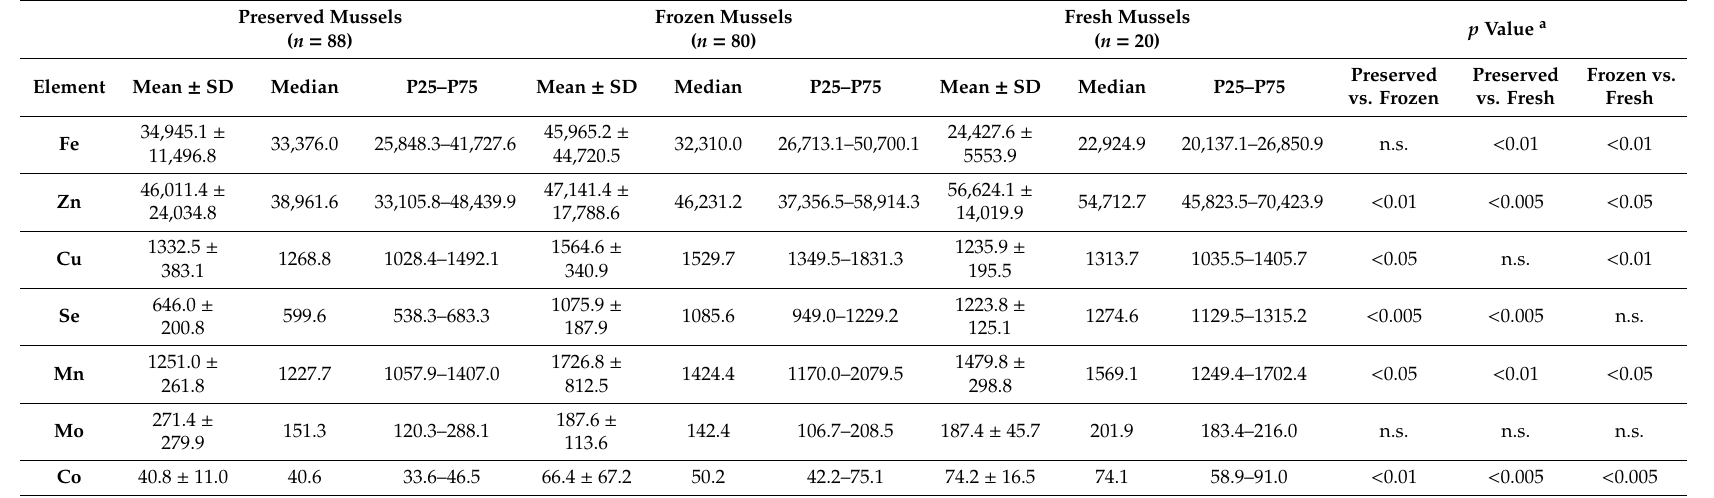
Table 2. Concentrations of essential in mussels from di ff erent types of conservation in the Spanish market. Results are expressed in ng /